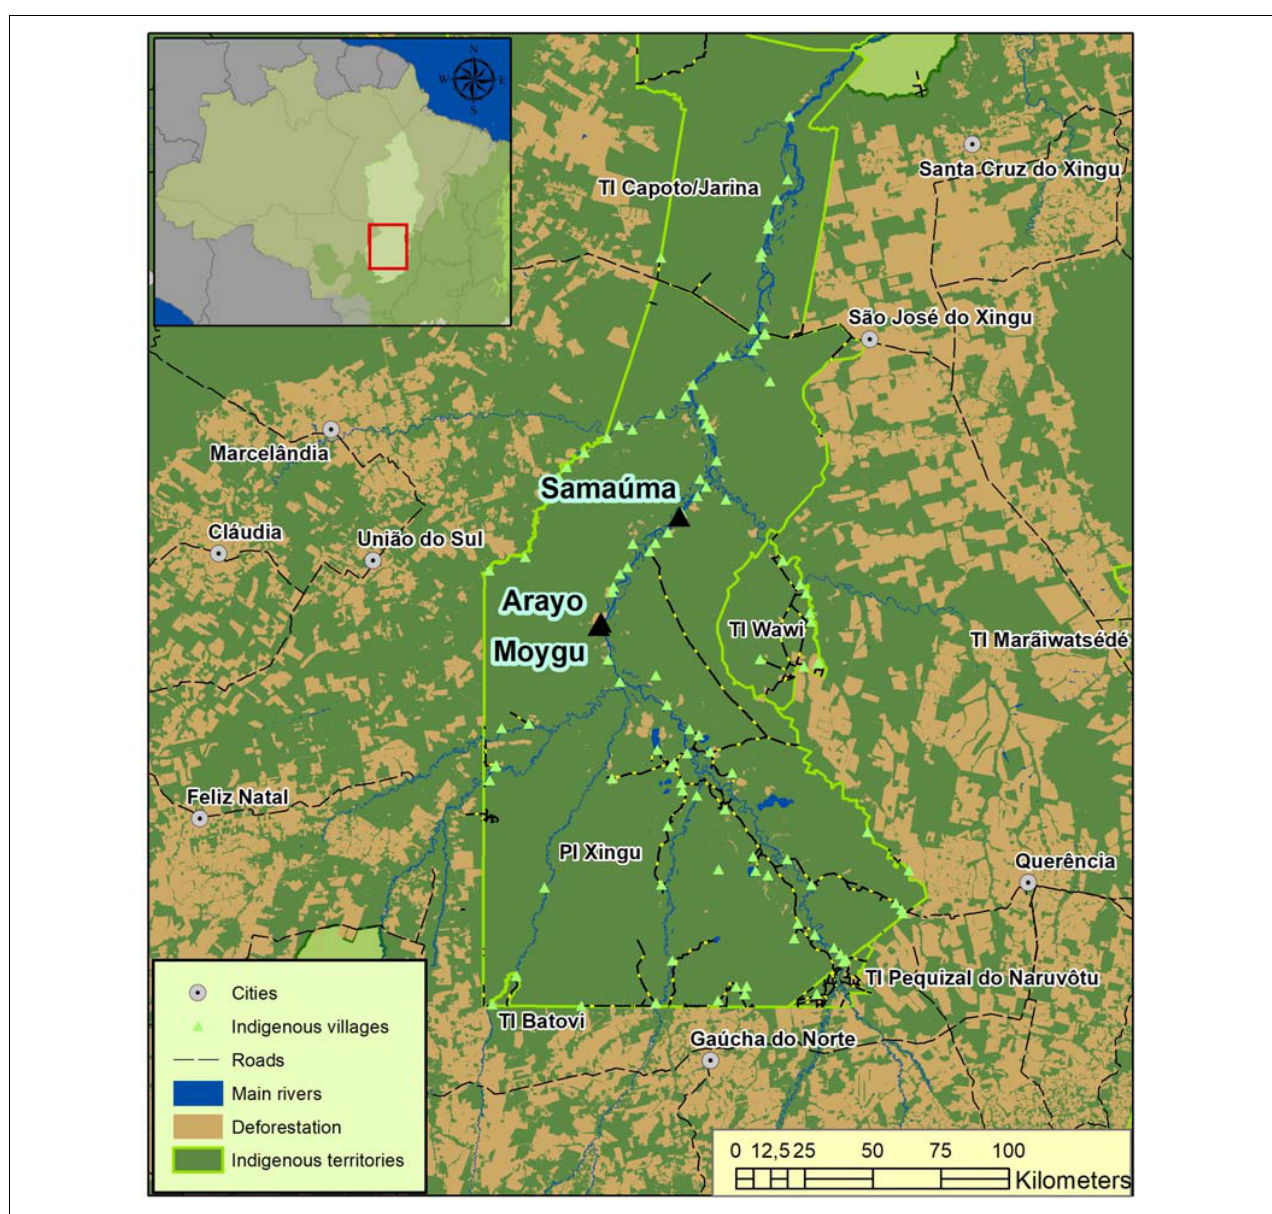
FIGURE 1 | Location of the Xingu River basin, and the villages of Samaúma Kawaiwete, Moygu Ikpeng, and Arayo Ikpeng within the boundaries of the TIX and surrounded by adjacent municipalities that have lost more than 66% of the forest cover in the last 40 years ( map by Ricardo Abad, courtesy Instituto Socioambiental, Xingu Program